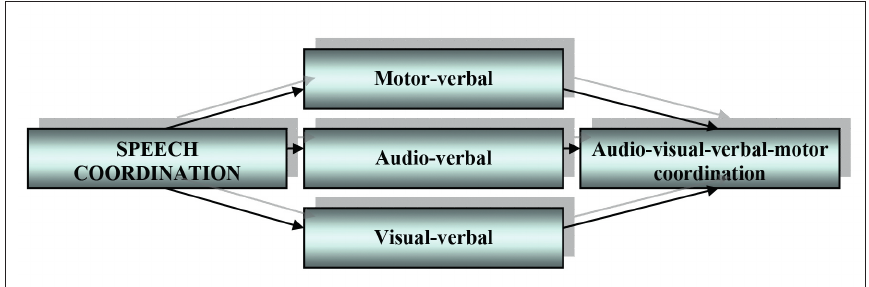
Figure 5. Content of the specialized perceptions/“senses” (Craijdan & Aftimiciuc,